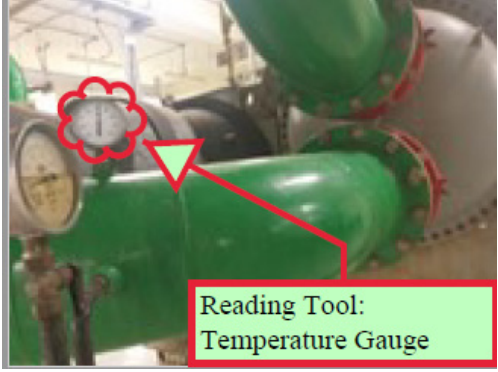
Figure 5. Cooling Tower Reading Tool.